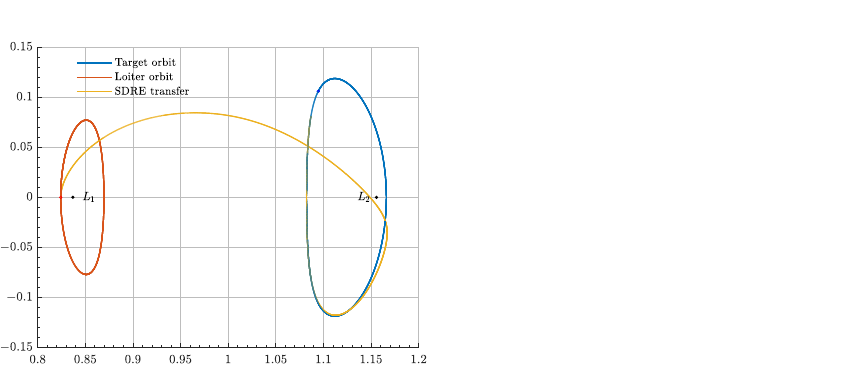
Figure 19. Absolute trajectory for the Lunar Gateway resupply mission during the long-range